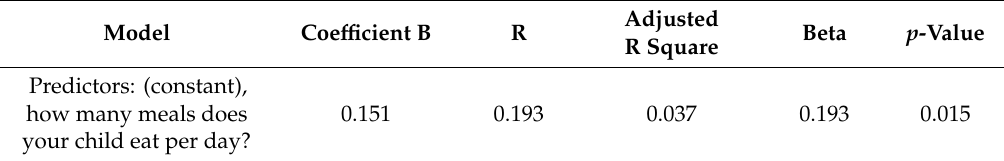
Table 4. Univariate logistic